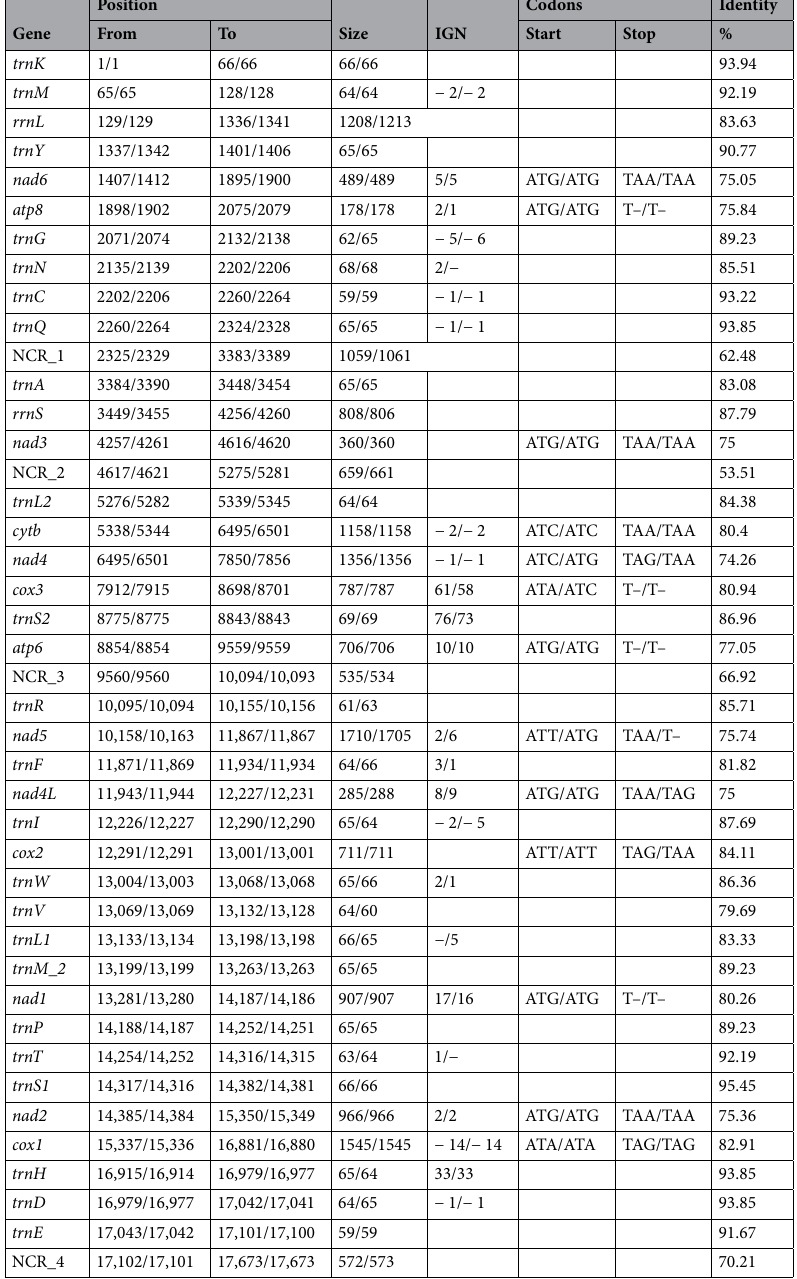
Table 1. Comparative table of the architecture of mitogenomes of P. brevipalpa (left) versus P. websteri (right). IGN stands for the intergenic region, where negative values indicate overlap. Intergenic regions larger than 150 bp are annotated as